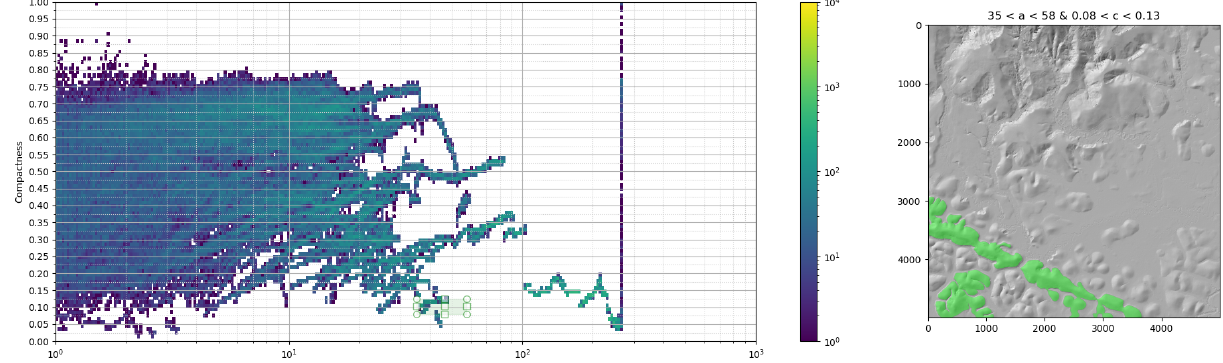
Figure 7. Left: Interactive selection on pattern spectrum (height and compactness) of the DTM with the max-tree. Right: Structures of the DTM corresponding to the selection are displayed with a green overlay on top of the hillshade visualization.